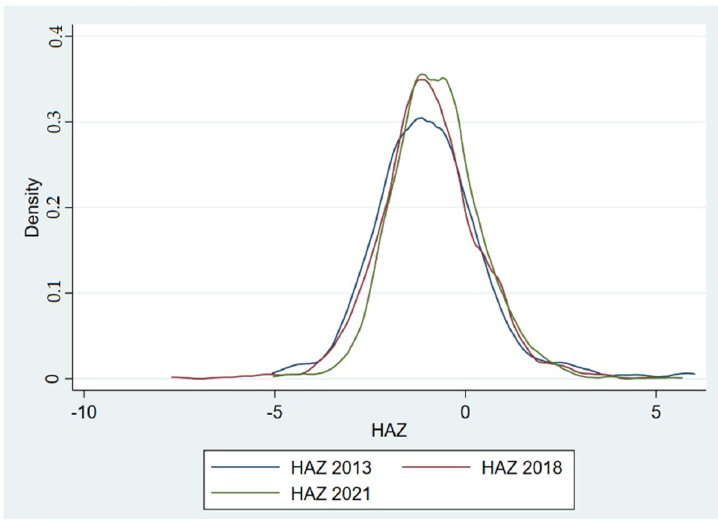
Figure 3. HAZ kernel density plots of 0–59 month children during 2013–2021. The average HAZ score among 0–59 month children from 2013 to 2021 increased by 0.22 SDs, from − 0.93 SDs to − 0.71 SDs. In contrast, the increase in HAZ score in stunted